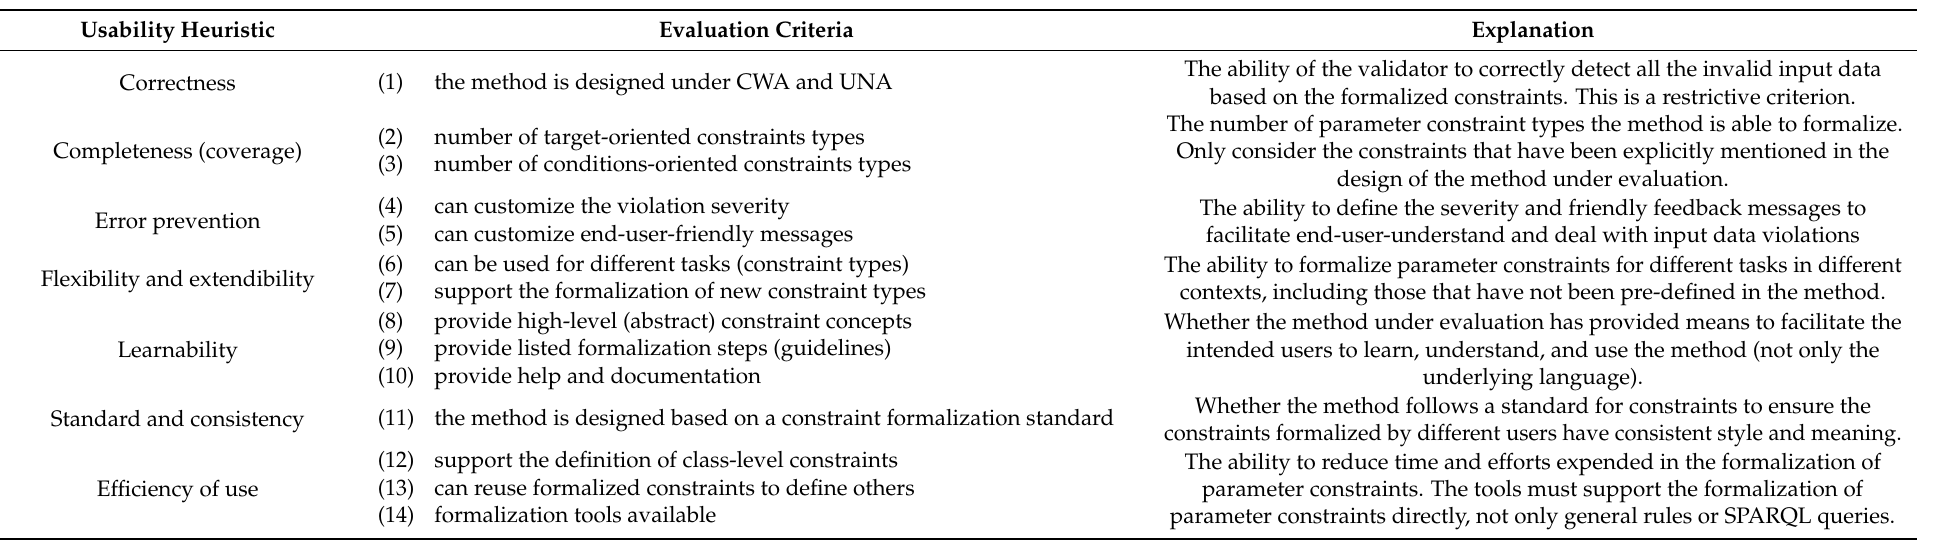
Table 6. Usability heuristics for the evaluation of parameter constraint formalization